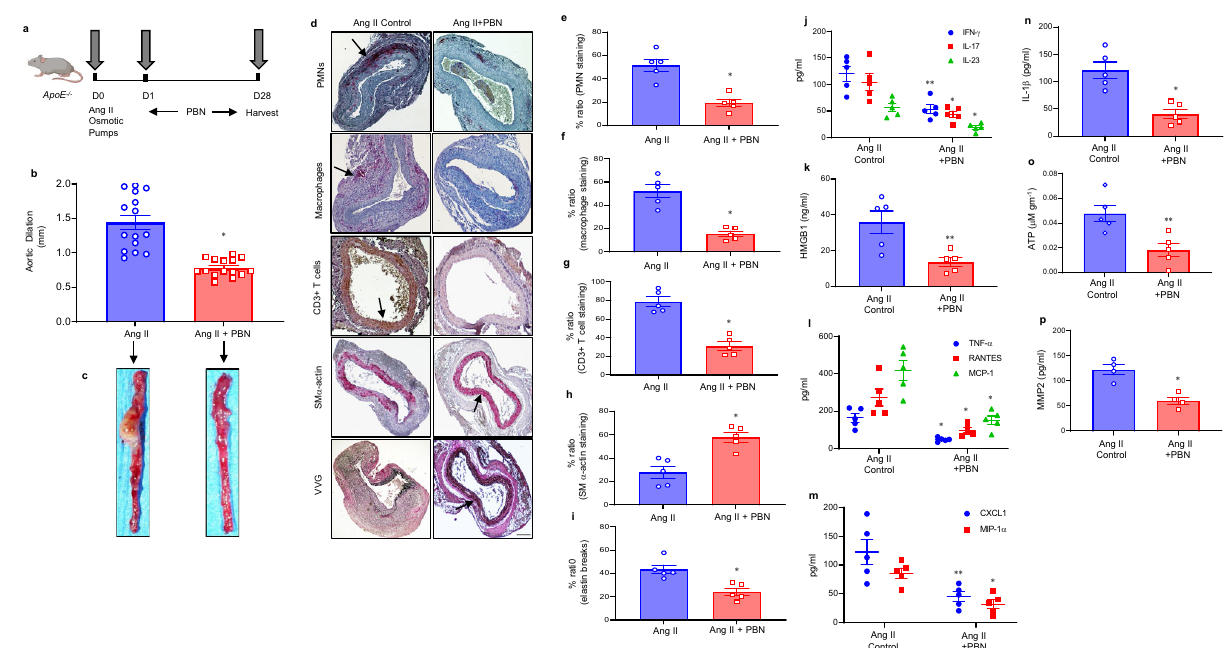
Fig. 4 Inhibition of Panx1 channels attenuates AAA formation in the Ang-II model. a Schematic depicting the Ang-II model of AAA in ApoE − / − mice. Osmotic pumps with either Ang II or saline (control) were inserted into the subcutaneous tissue of mice with/without treatment with PBN. Aortic diameter was measured on day 28, and tissue was harvested for further analysis. b Ang-II mice treated with PBN demonstrated signi fi cantly decreased aortic diameter compared with angiotensin treated mice alone. * P = 0.001; n = 15 mice/group. c Representative images of aortic phenotype in all groups. d – i Comparative histology performed on day 28 demonstrates that Ang-II-treated ApoE − / − mice administered with PBN have decreased polymorphonuclear neutrophil (PMNs), macrophage (Mac-2), CD3 + T-cell in fi ltration, and elastic- fi ber disruption (Verhoeff – Van Gieson staining), and increase in SM- α -actin expression compared with mice treated with Ang II alone. Arrows indicate areas of immunostaining. * P = 0.007 ; n = 5 mice/group. Scale bar is 200 μ m. j – n Aortic in fl ammation is mitigated by Panx1 antagonism in the Ang II model of AAA. Aortic tissue from Ang-II-treated ApoE − / − mice after PBN administration showed a signi fi cant attenuation in pro-in fl ammatory cytokine/chemokine production compared with Ang-II-treated mice alone. * P = 0.007 vs. respective Ang-II controls; ** P = 0.01; n = 5 mice/group. o A signi fi cant decrease in aortic tissue ATP content was observed in PBN-treated mice compared with Ang-II-treated mice alone. * P = 0.01; n = 5 mice/group. p Expression of MMP2 in aortic tissue was signi fi cantly attenuated in PBN- treated mice compared with elastase-treated mice alone. * P = 0.02; n = 4/group. Data are represented as mean values ± SEM and comparative statistical analyses were done by two-tailed t